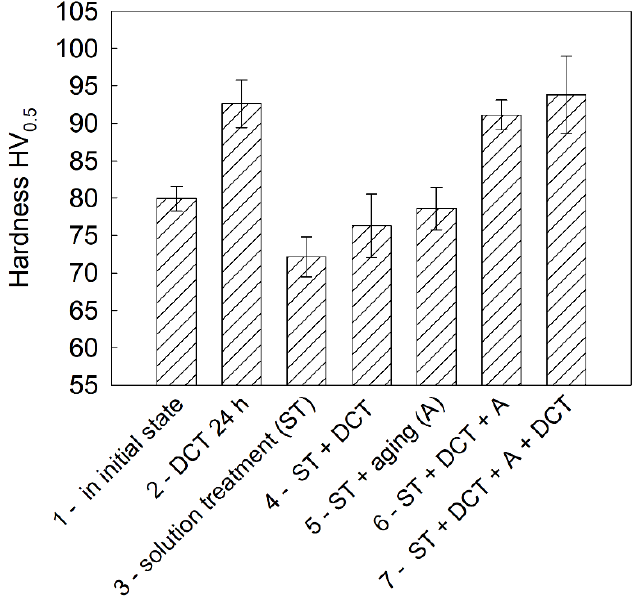
Figure 7. Changes in Vickers microhardness values of the Mg-Y-Nd alloy in the initial state and after different heat treatment variants in combination with DCT.